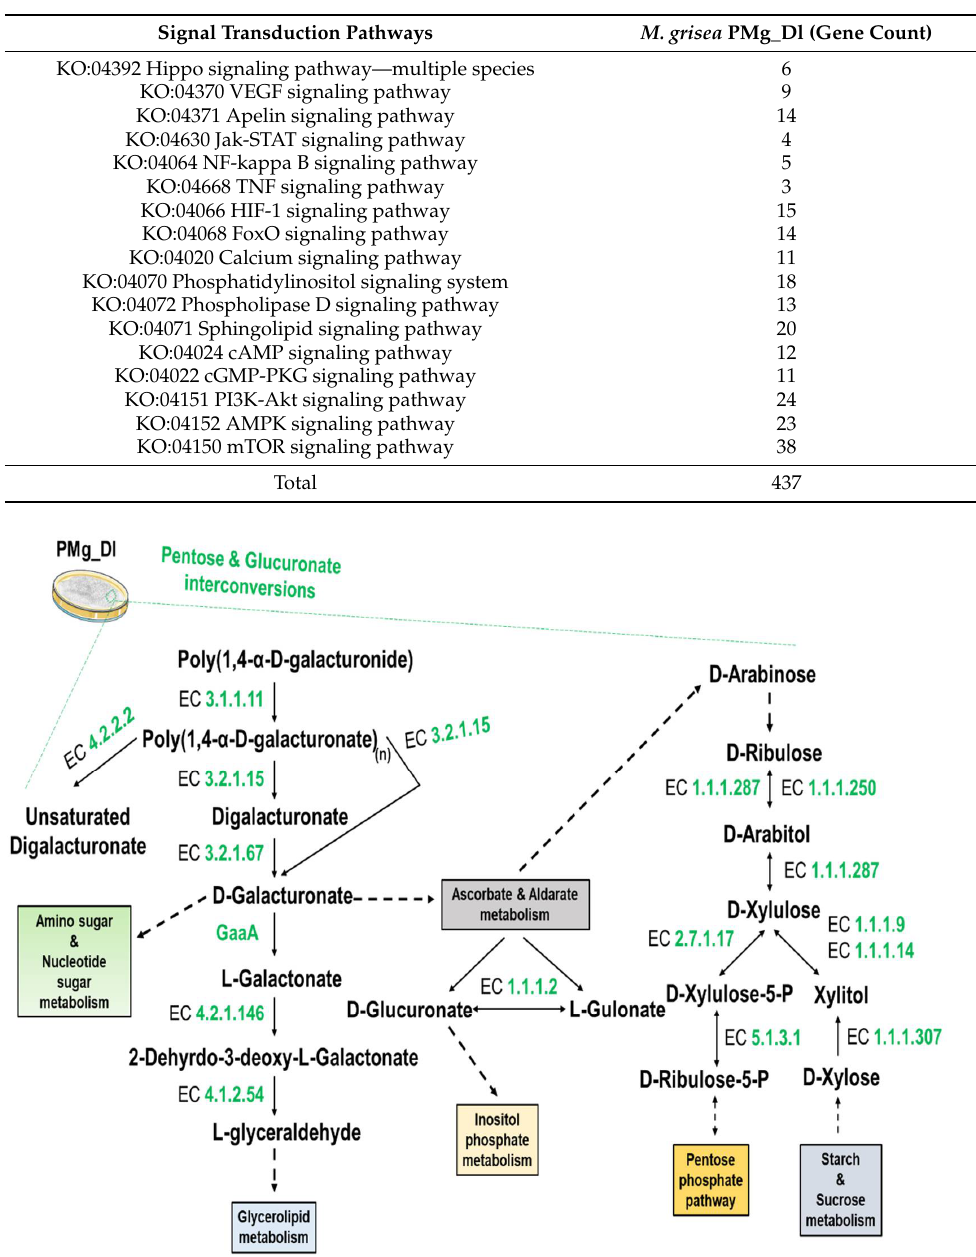
Figure 8. Schematic illustration of pentose and glucoronate interconversion pathways showing the pectin and xylan breakdown routes and main enzymes. The sysnames of enzymes related to the biosynthetic machinery are depicted in green-colored EC numbers: EC3.1.1.11 : Pectin pectylhy-